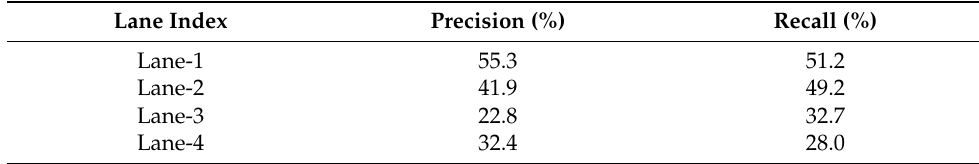
Table 1. Classification Result of AlexNet (vision